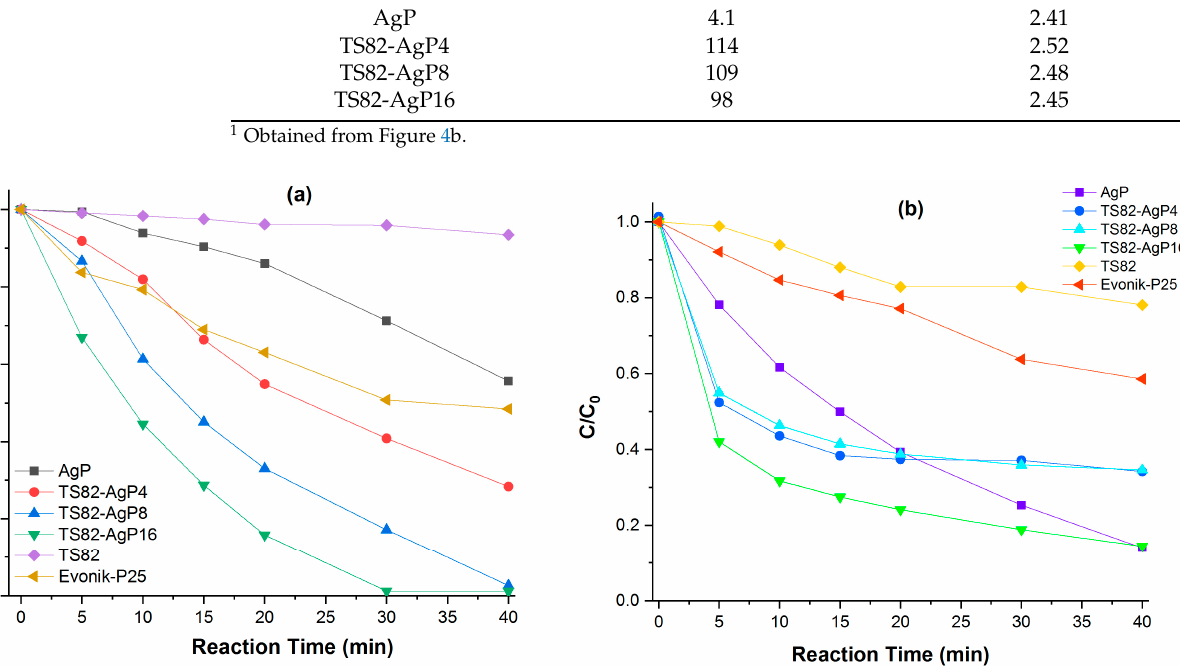
Figure 5. Plot of C/C 0 versus reaction time (solar light irradiation time) of different photocatalyst samples performed with ( a ) RhB and ( b ) MB dye solutions. Table 2. Photocatalytic reaction rate constants of RhB and MB dye degradation under solar light.